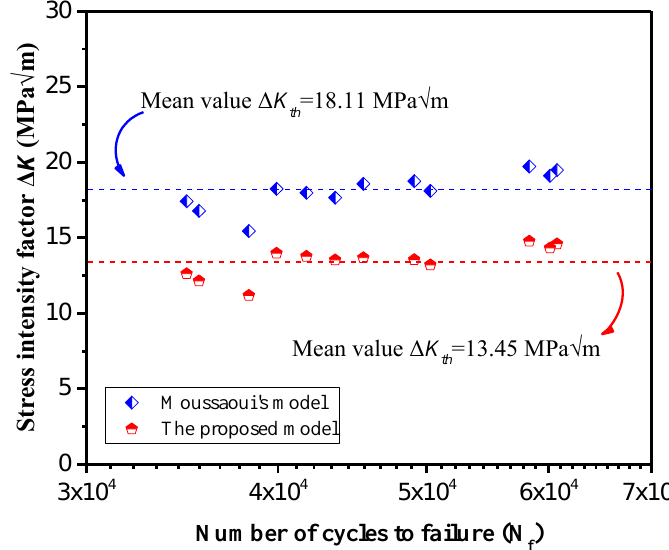
Figure 11. The relationship between the threshold stress intensity factor Δ K th and the fatigue